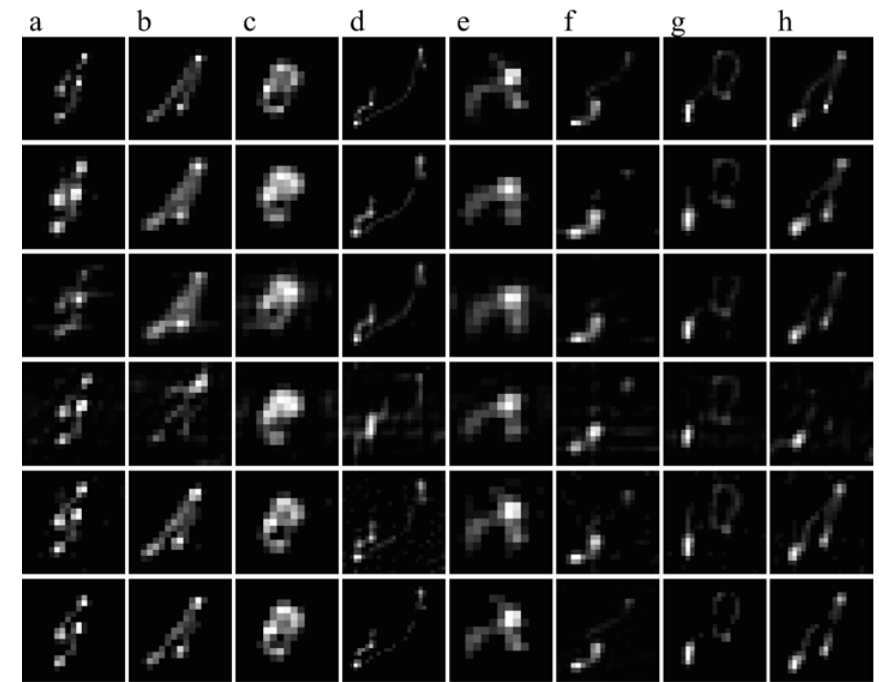
Figure 4. Comparison results for blur kernel estimation. (a)-(h): 8 blur kernels listed in Table 1. First row: ground truth blur kernel. Second row: method in [35]. Third row: method in [36]. Fourth row: method in [37]. Fifth row: method in [38]. Last row: proposed method.